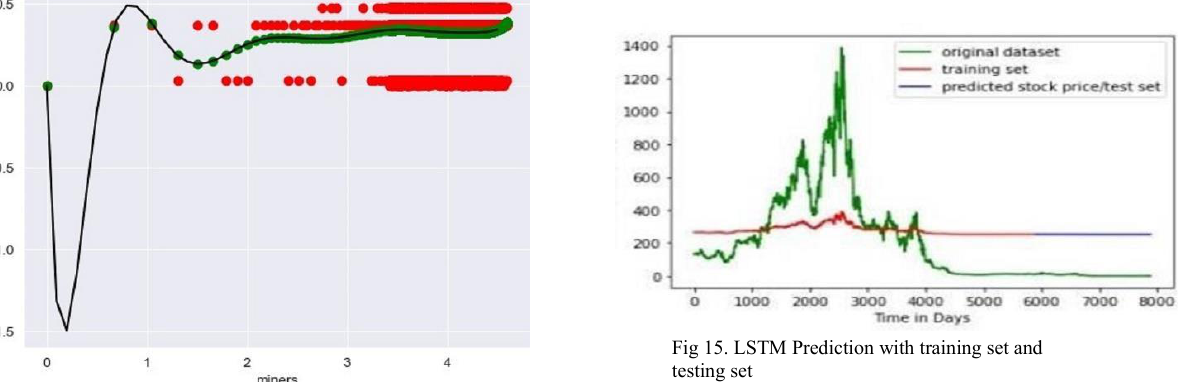
Fig 14. Plot of original values.